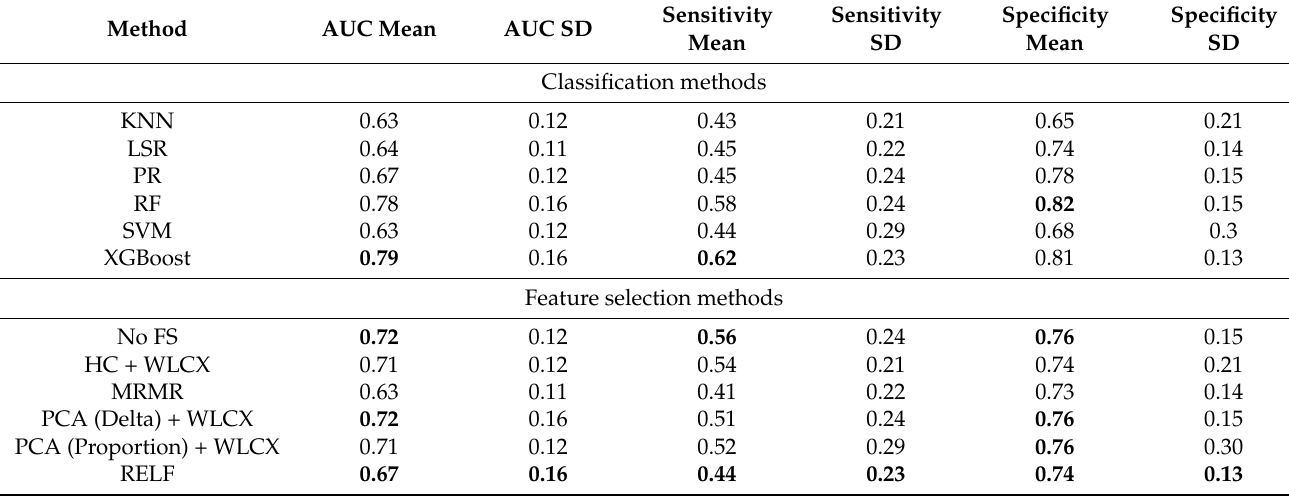
Table 3. Mean AUC for each classifier across different sample sizes, balancing, signal intensity and feature selection methods in the validation set. Best mean AUC, Sensitivity and Specificity values are in